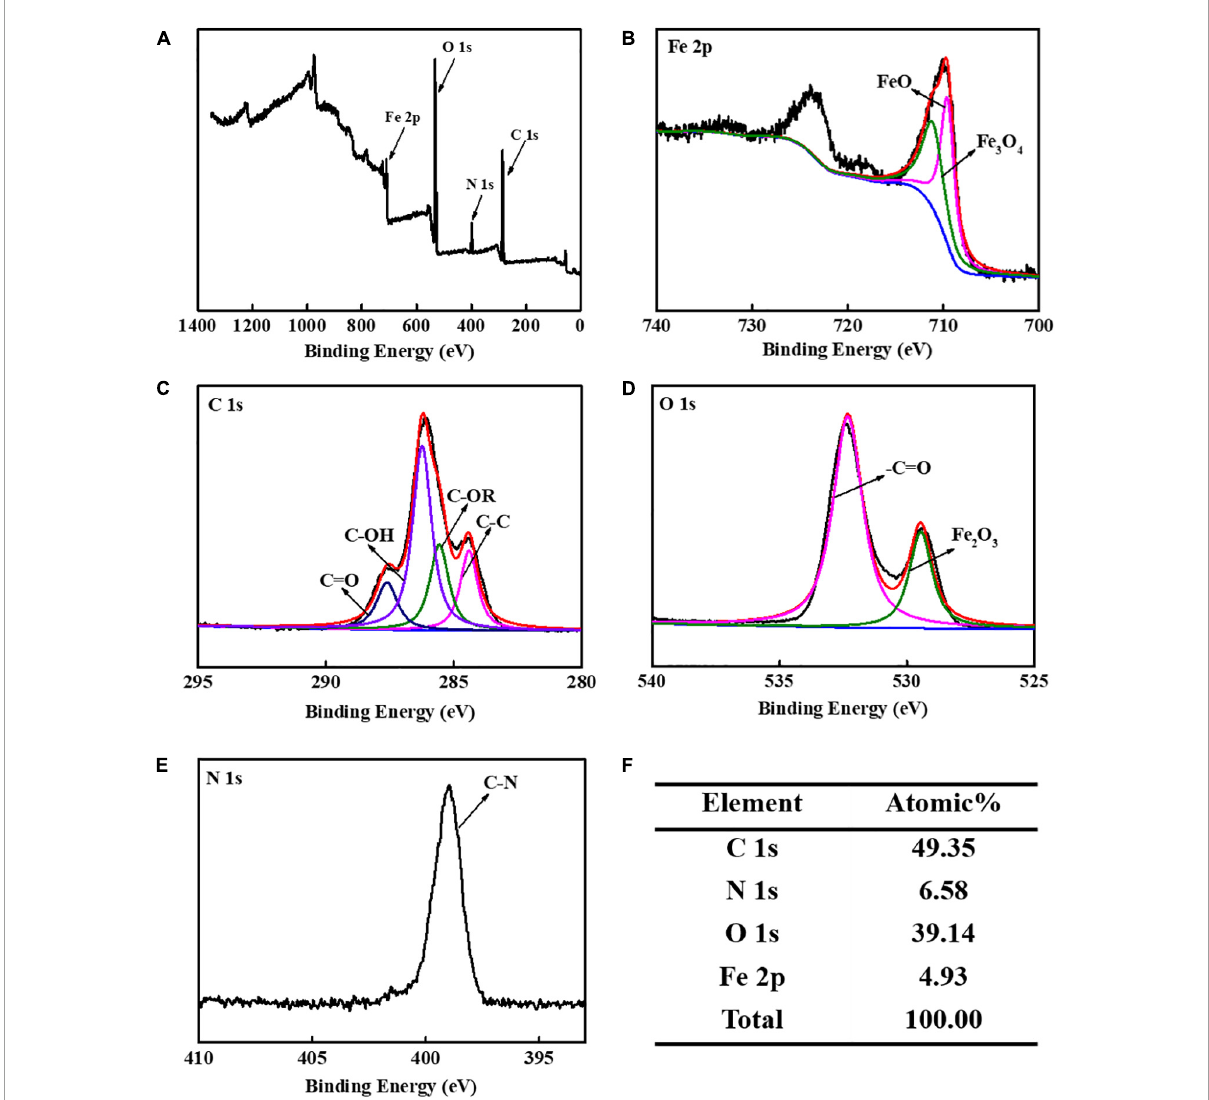
FIGURE3 X-ray photoelectron spectroscopy (XPS) analysis of CS-Fe 3 O 4 nanoparticles. (A) XPS profile. (B) High-resolution XPS of Fe 2p. (C) High-resolution XPS of C 1s signal. (D) High-resolution XPS of O 1s signal. (E) High-resolution XPS of N 1s signal. (F) Elemental atomic percentages of CS-Fe 3 O 4